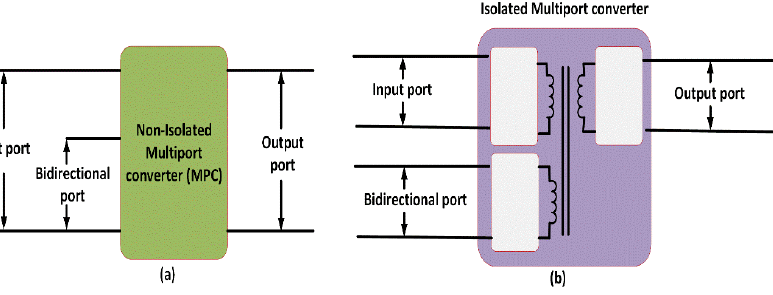
Figure 3. The typical schematic structure of a multiport converter, ( a ) non-isolated and ( b ) isolated. Table 1. Comparative analysis of the different DC-DC converter topologies [3].